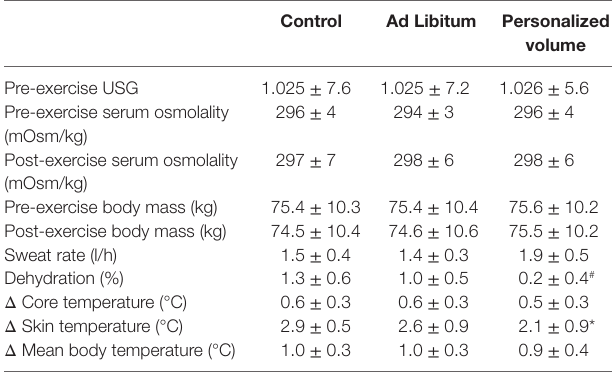
Table 1 | Urine-specific gravity (USG), serum osmolality, sweat rate, dehydration, and changes in temperatures at the three experimental